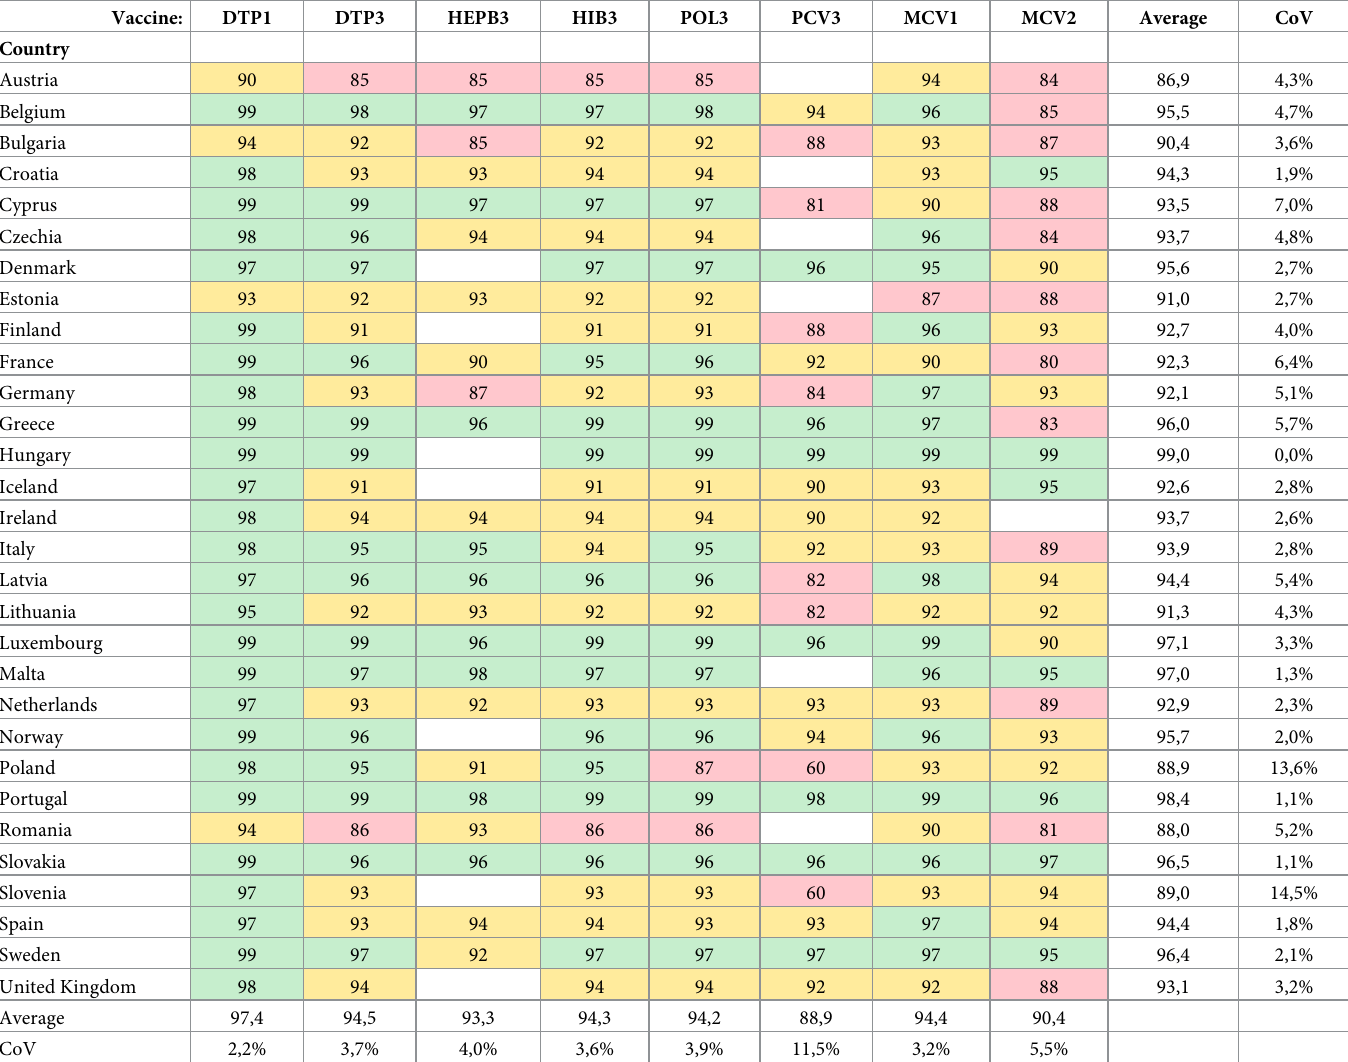
Table 2. 2018 vaccination coverage by vaccine and by